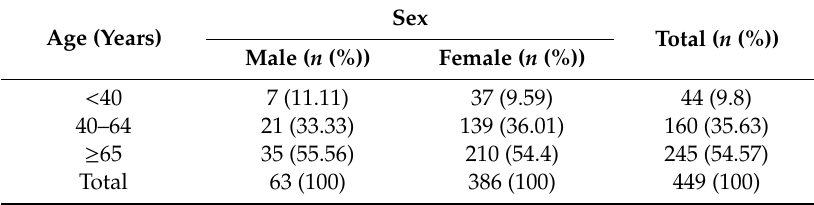
Table 1. Age and sex distribution of the patients in this